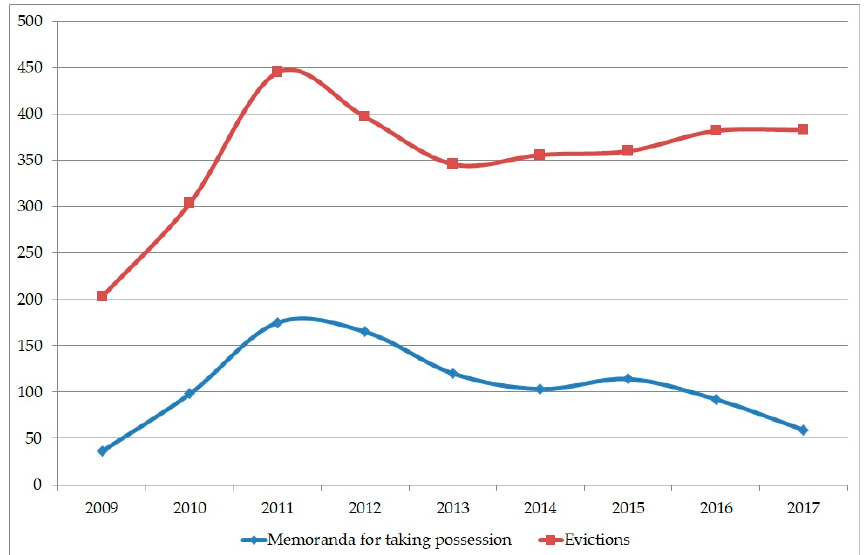
Figure 5. Number of Proceedings of the Common Service of Las Palmas de Gran Canaria per year. Data: Common Service of Notifications and Liens of the Judicial District for Las Palmas de Gran Canaria. Own production.